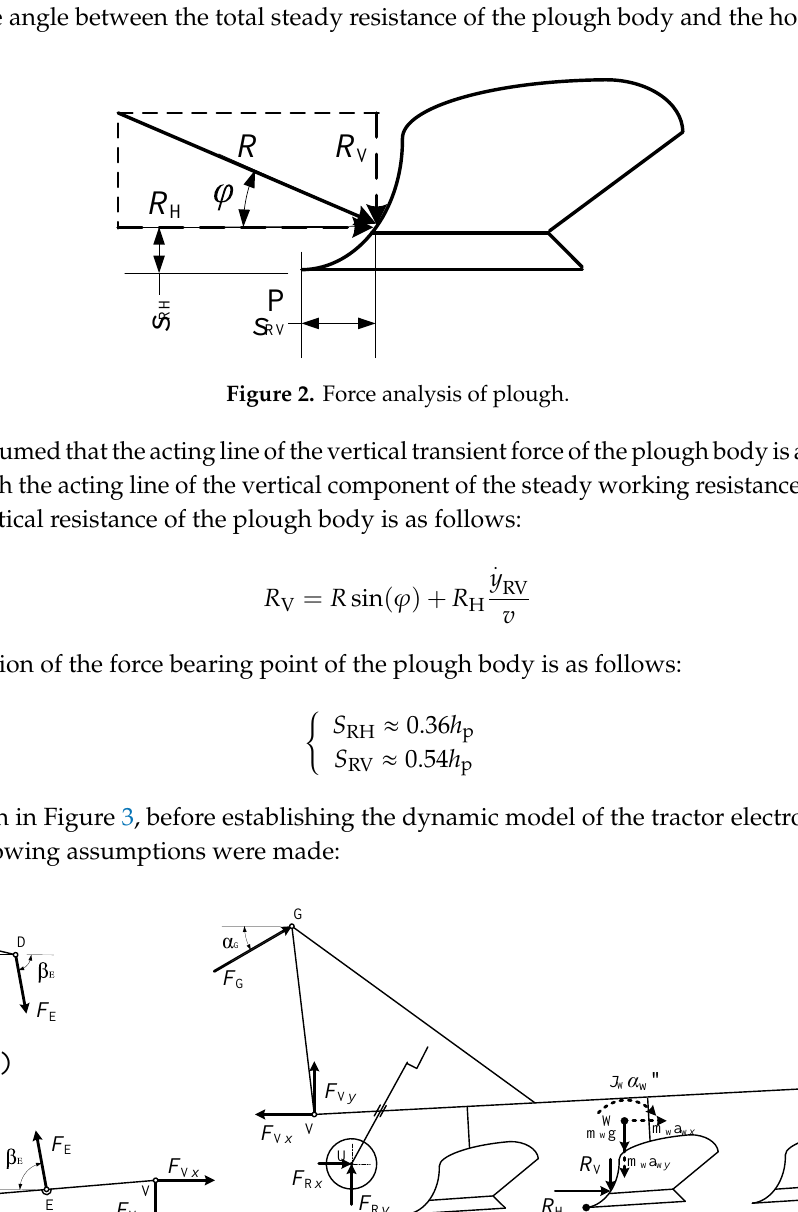
Figure 2. Force analysis of plough.